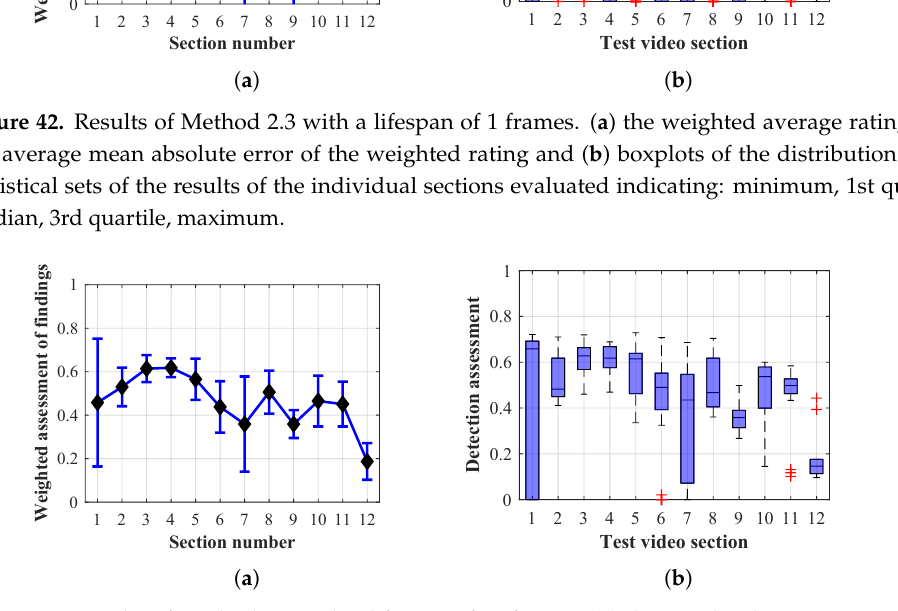
Figure 43. Results of Method 2.3 with a lifespan of 12 frames. ( a ) the weighted average rating with the average mean absolute error of the weighted rating and ( b ) boxplots of the distribution of the statistical sets of the results of the individual sections evaluated indicating: minimum, 1st quartile, median, 3rd quartile, maximum.